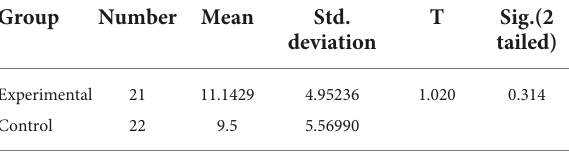
TABLE 3 Independent samples t -test for the difference in the mean scores of (WDT) pre-test for the experimental group and the control group.